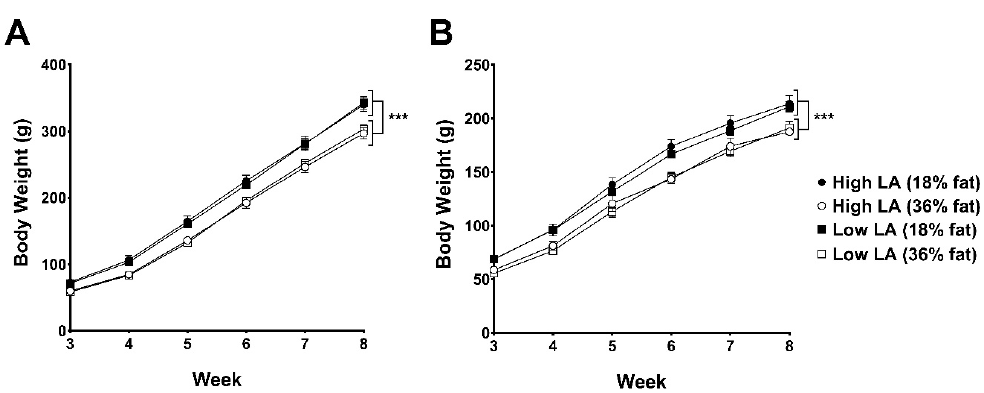
Figure 1. Body weights of ( A ) male and ( B ) female offspring postweaning up to 8 weeks of age exposed to either a high LA (18% fat) diet (closed circles), high LA (36% fat) diet (open circles), low LA (18% fat) diet (closed squares) or a low LA (36% fat) diet (open squares) during gestation and lactation. Offspring were weaned onto a chow diet. Values are means ± SEM and n = 6–9 per group. The effects of dietary fatty acid ratio and dietary fat content were determined using a two-way repeated measures ANOVA. *** indicates a significant effect of maternal dietary fat content ( p < 0.0001) on body weight.